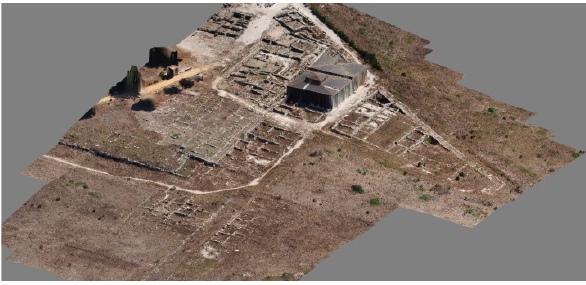
Figure 9. 3D model of the area of